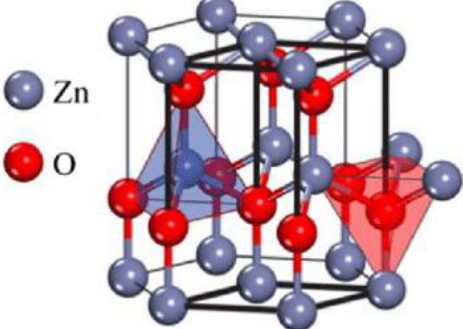
Figure 1. Hexagonal (wurtzite) structure of ZnO [14].